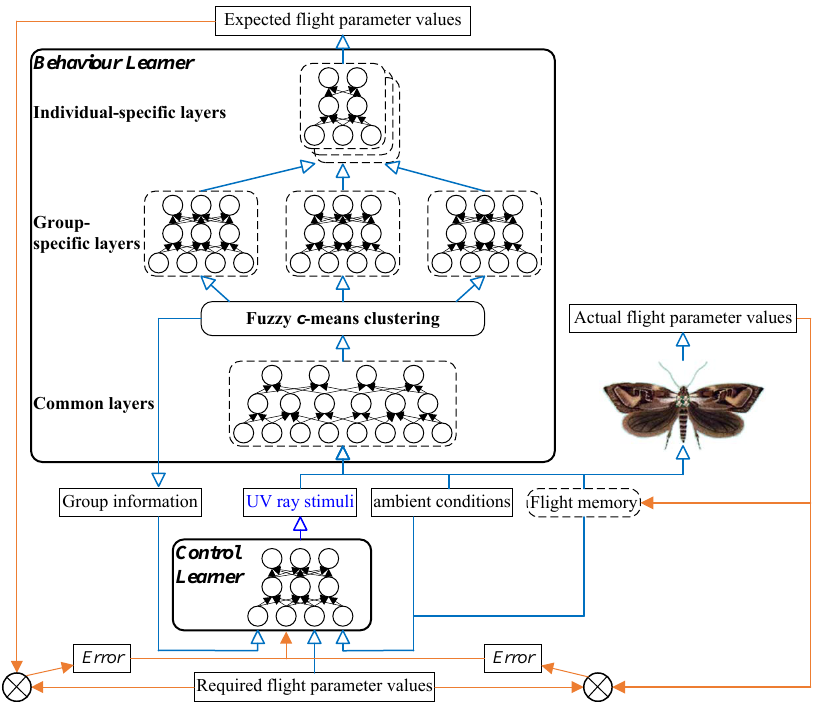
Figure 2. The framework of the fuzzy deep learning model for cyborg control. The Control Learner and the three sub-learners of the Behavior Learner are all constructed using the proposed PFDDAE